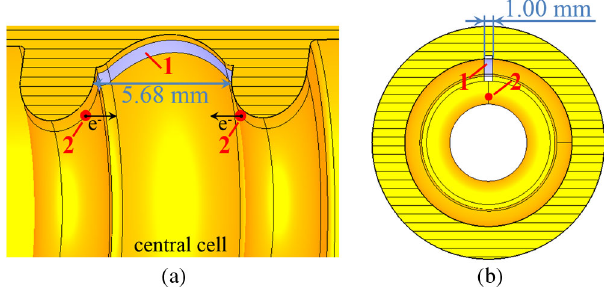
FIG. 5. (a) Longitudinal and (b) transverse cross section views of the PIC simulation model of the structure with axisymmetric elliptical central cell sidewall in CST. 1, the 1.0 mm wide sidewall strip section assigned with SEE properties; 2, the sources of electrons where the peak electric field is located.